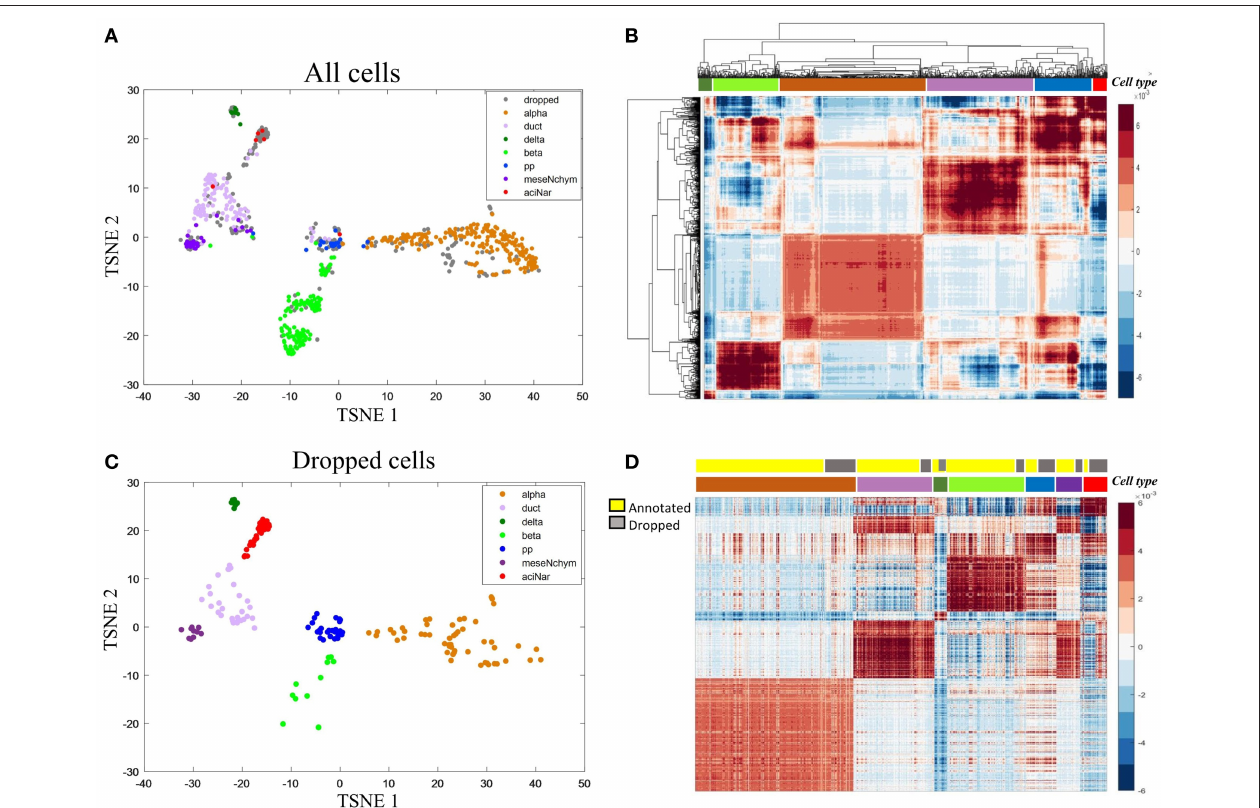
FIGURE 3 | Case study on the diabetes (A) The two-dimensional projection of the global-sample pattern matrix Y of diabetes1 dataset using t-SNE. Colors represent different cell types where gray dots specifically mean dropped cells. (B) Hierarchical clustering diagram of all cells. The colors at the top represent the references labels (see color legend in A ). The purple represents the ductal cell and mesenchymal cell because these two cells are mixed together. (C) For the previously dropped cells, HCI can cluster them into different groups corresponding to known cell types well. Thus, it is more efficient on cell type identification with less non-identified cells. (D) Heatmap representation of Y of all cells. The first color bar represents the type of annotated cell and ambiguous cells and the second bar represents the seven cell types as the same as in (A)